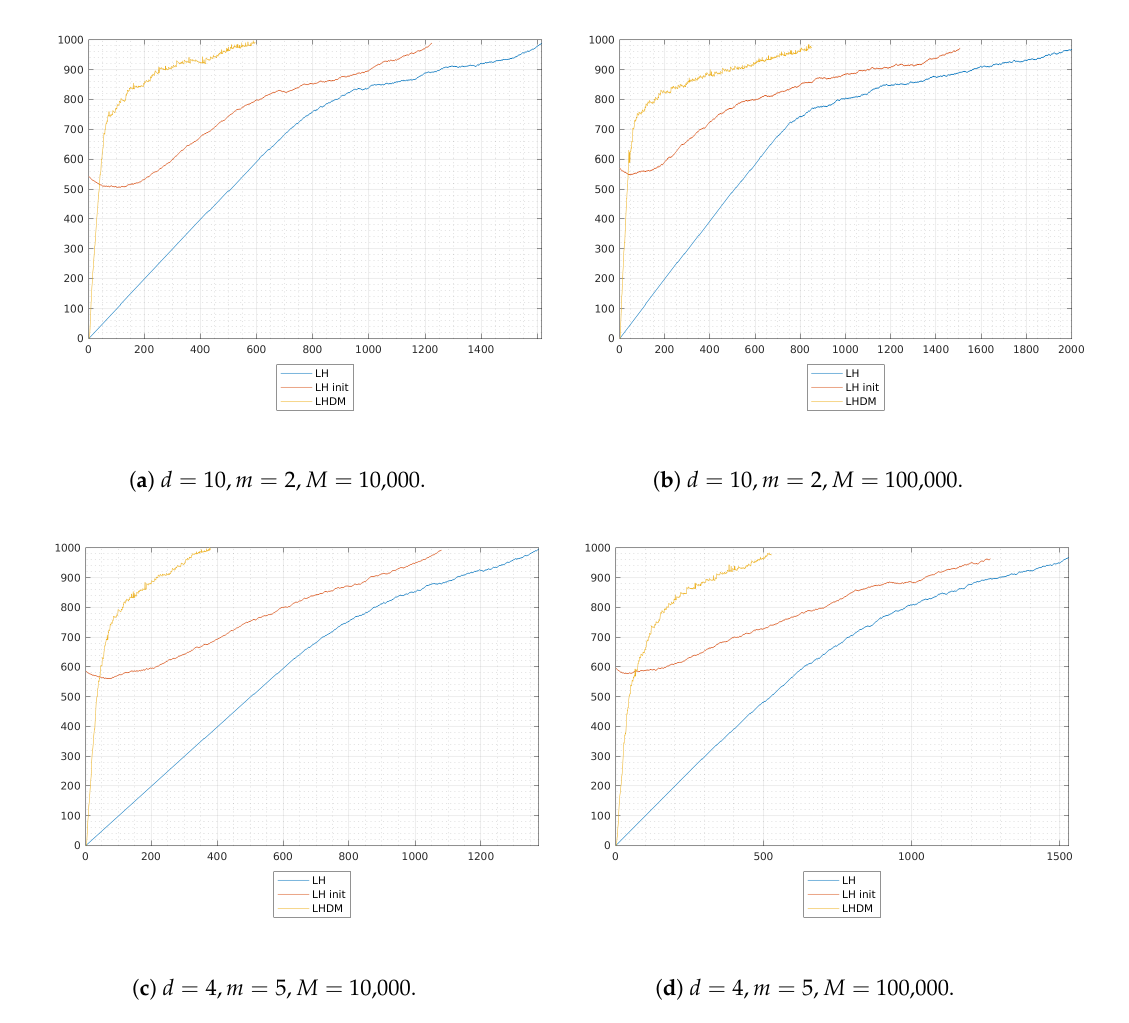
Figure 3. The evolution of the cardinality of the passive set P along the iterations of the three LH algorithms for Halton points’ tests. Table 5. Results of numerical tests on Halton points: compr = M / mean ( cpts ) is the mean compression ratio obtained by the three methods listed; t LH / t Titt is the ratio between the execution time of LH and that of Titterington algorithm; t LH / t LHDM ( t LHI / t LHDM ) is the ratio between the execution time of LH (LHI) and that of LHDM; cpts is the number of compressed Tchakaloff points and momerr is the final moment